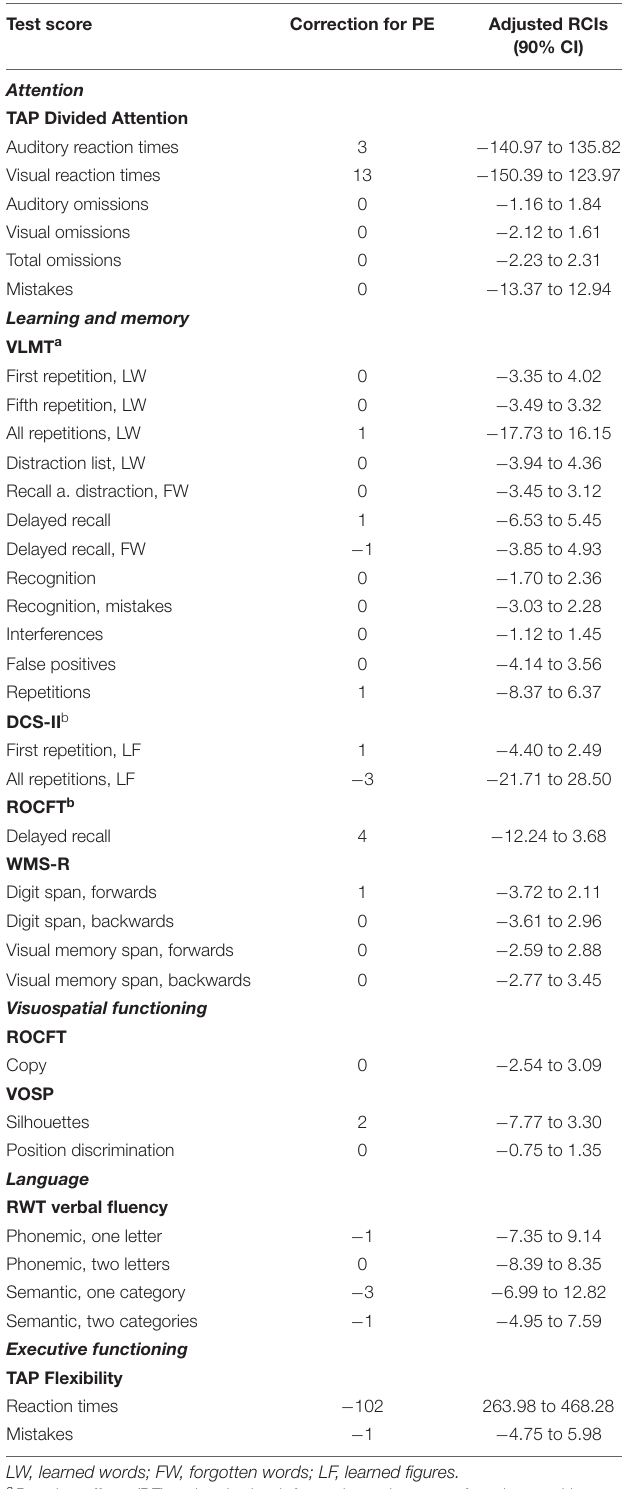
TABLE 3 | Practice-effect (PE)-adjusted reliable change indices (RCIs) and respective 90% confidence intervals (CI) for each neuropsychological test